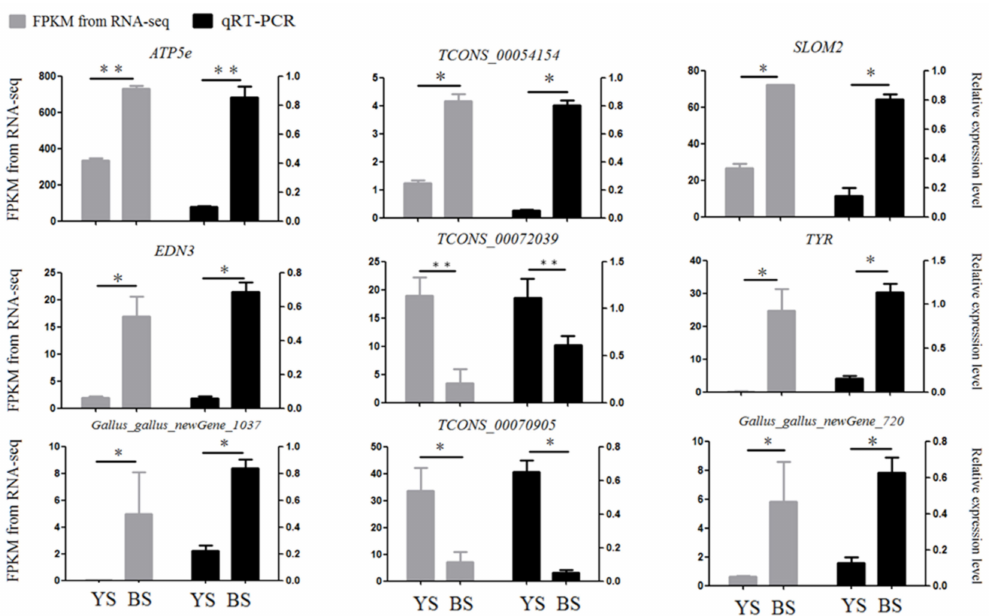
Figure 5. Quantitative validation of transcriptome sequencing results. * represents p < 0.05, ** repre- sents p < 0.01.